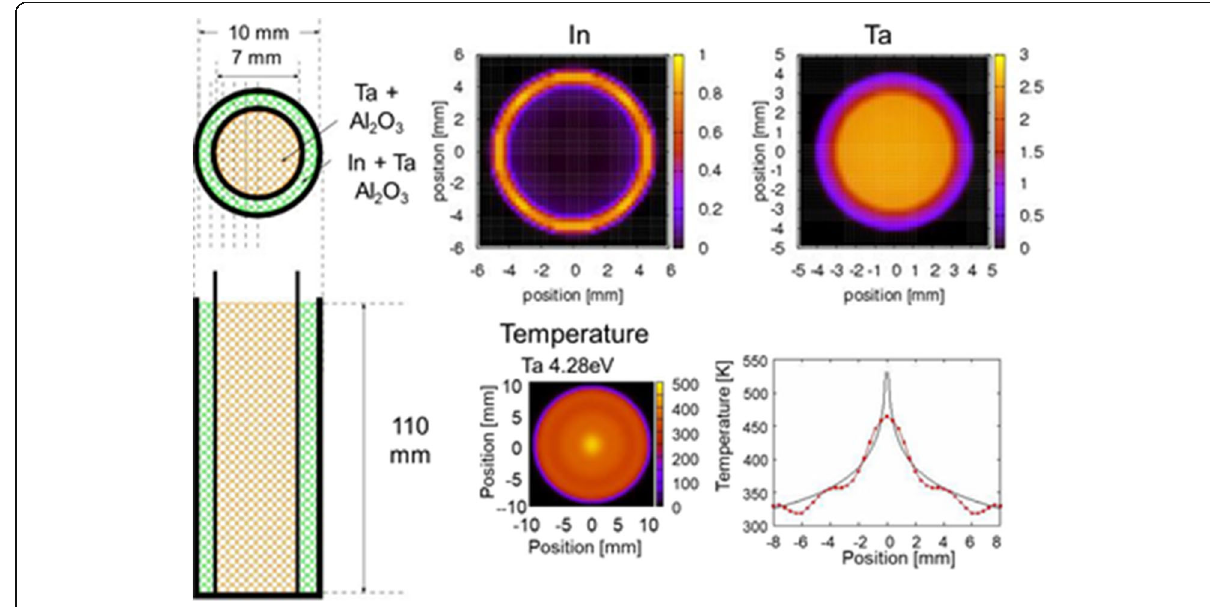
Fig. 13 Example of the resonance imaging